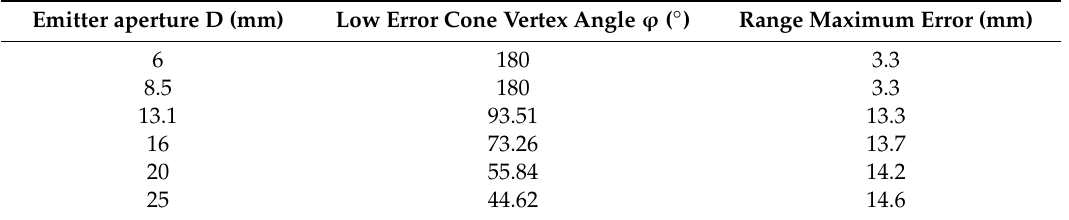
Table 1. Low error cone angle and range maximum error as a function of the aperture